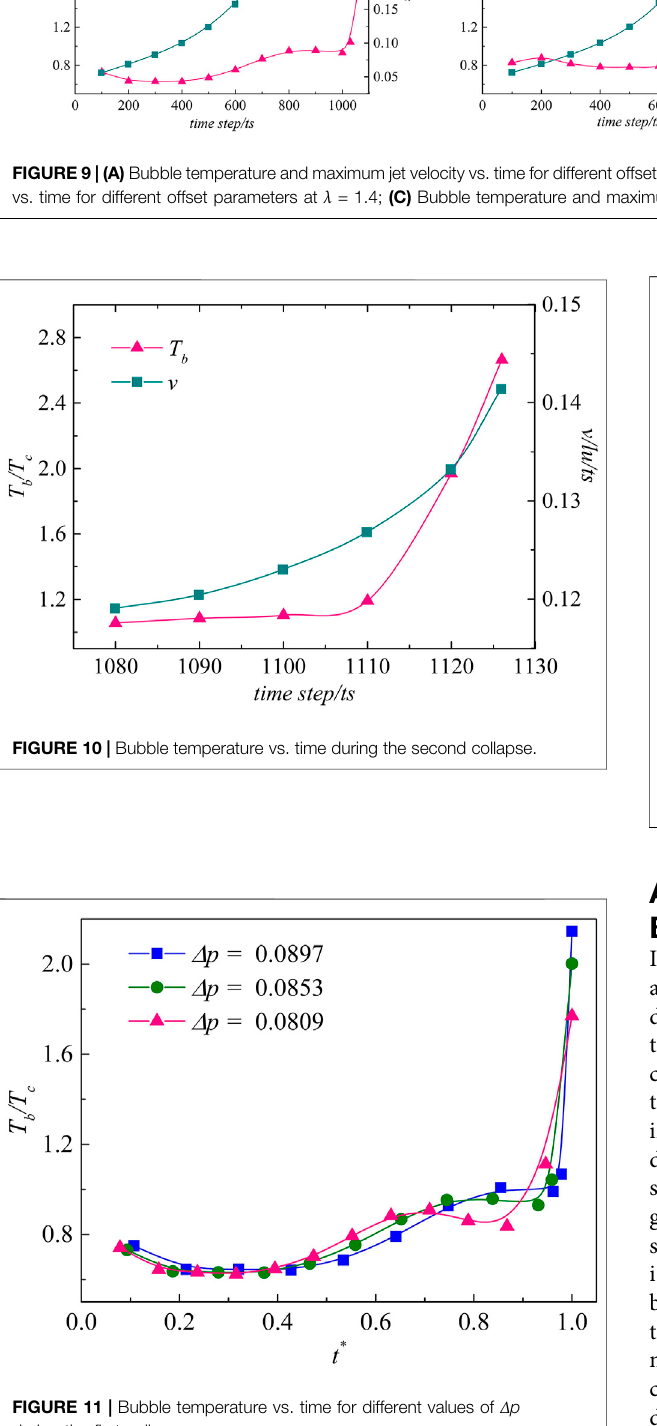
FIGURE 11 | Bubble temperature vs. time for different values of Δ p during the fi rst collapse.